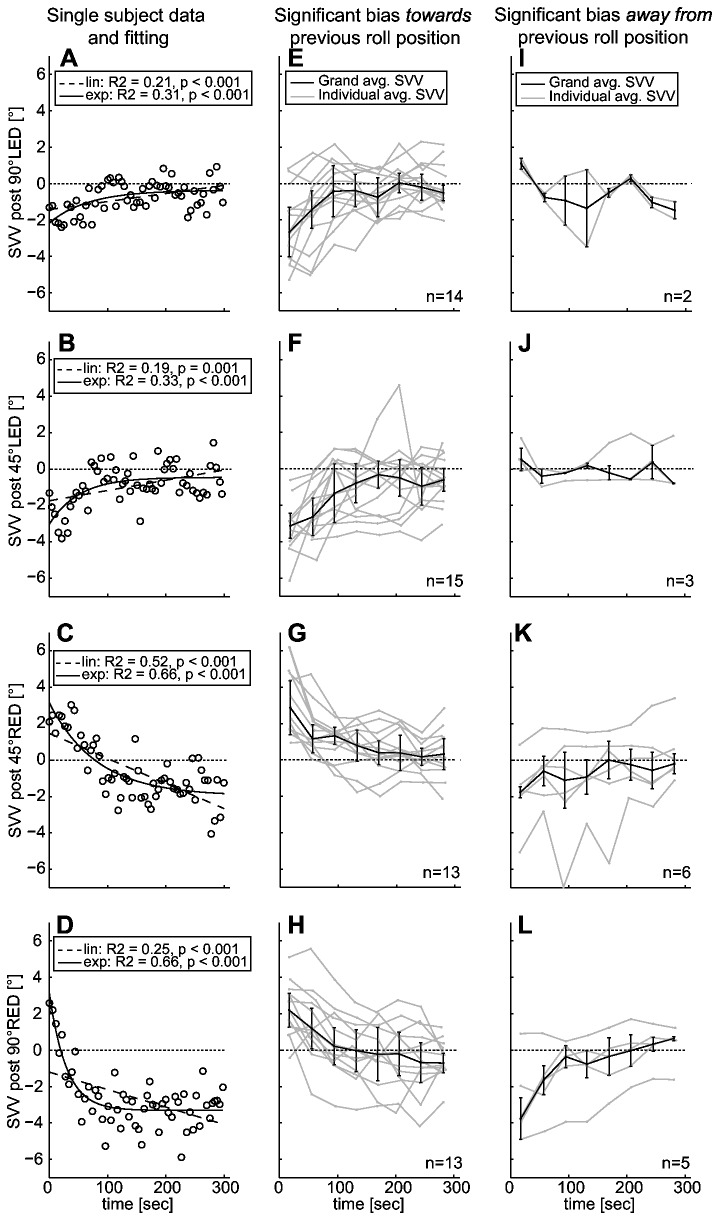
Illustration of perceived vertical upon return to upright position after prolonged roll.The left column (panels A-D) shows both single subject raw data (with circles referring to individual SVV adjustments) and linear (dashed line) and exponential (solid line) fits. R2- and p-values of fitting are provided in inlets. Runs [in grey: individual traces; in black: median (± one MAD) traces] with significant exponential decay were further categorized based on the direction of the post-tilt bias: runs that were initially biased towards the previous roll orientation are shown in the middle column (panels E-H), runs that were biased away from the previous roll orientation are presented in the right column (panels I-L), always indicating the number of traces (n) that met the criteria. To improve the illustration of drifting traces in the middle and right column, single adjustments were assigned to one of ten bins of equal length and the individual median was calculated. However, the fit was obtained from the raw data. The dashed horizontal lines refer to perfectly accurate (earth-vertical) adjustments.